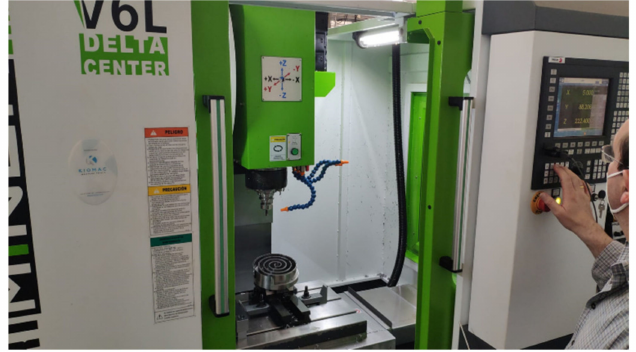
Figure 18. One of the three NC milling